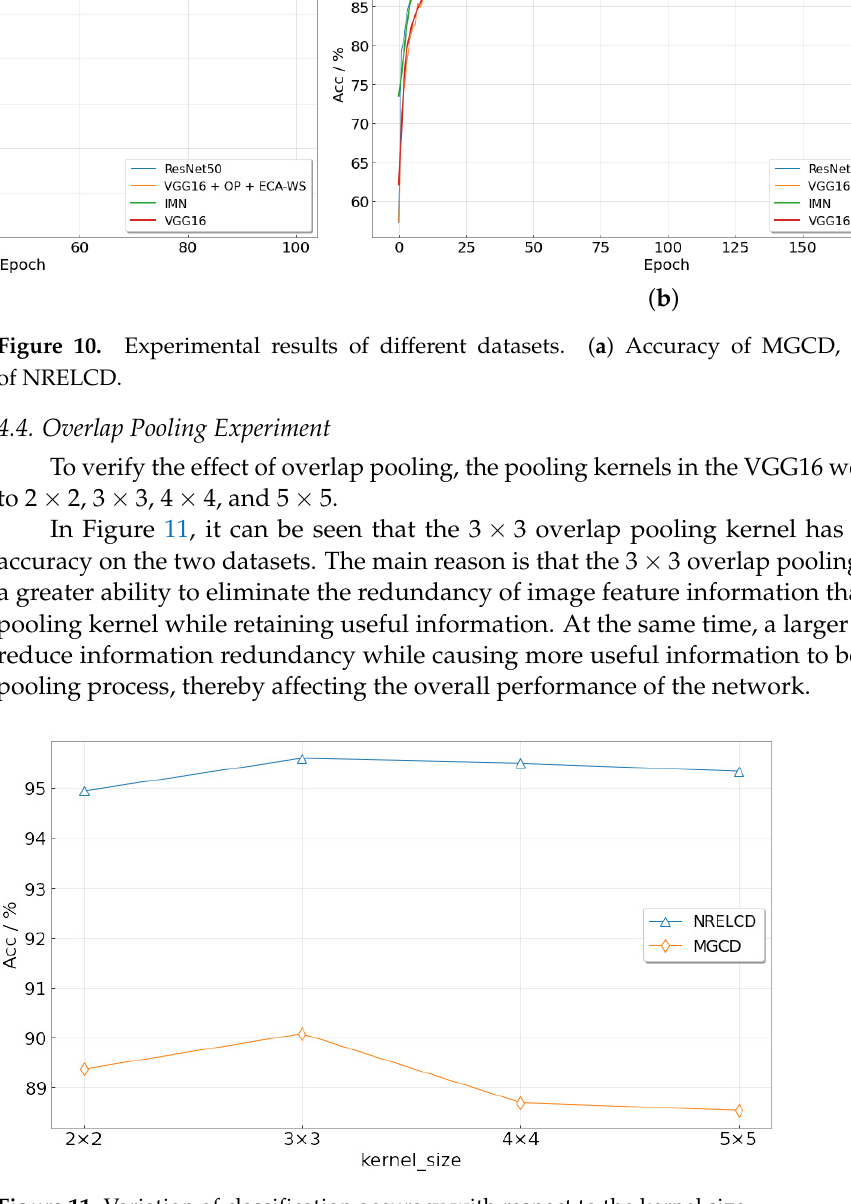
Figure 11. Variation of classification accuracy with respect to the kernel